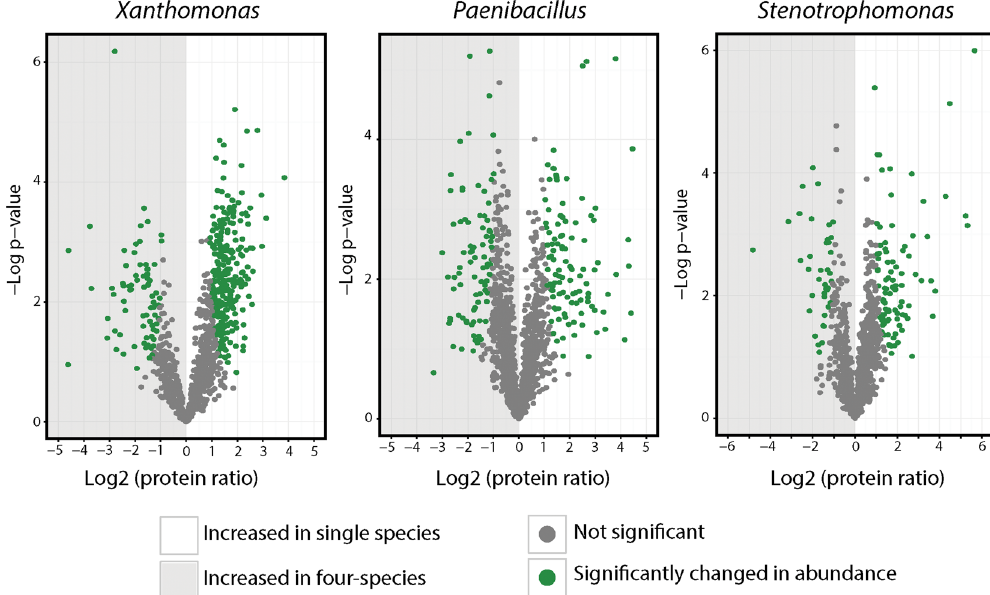
Figure 3. Label free quantification of proteins between five biological replicates of single- and four-species biofilm. Proteins with significant changes in abundance were identified using a modified Welsh t-test 61 with an S0 constant of 1 and valid values in at least 60% of both single species and four-species biofilm (three out of five replicates for both conditions). Correction for multiple hypothesis testing was performed with permutation based FDR with a significance threshold of 0.05. In total, 194, 352 and 132 proteins from Paenibacillus , Xanthomonas and Stenotrophomonas , respectively, differed significantly between the single and four-species